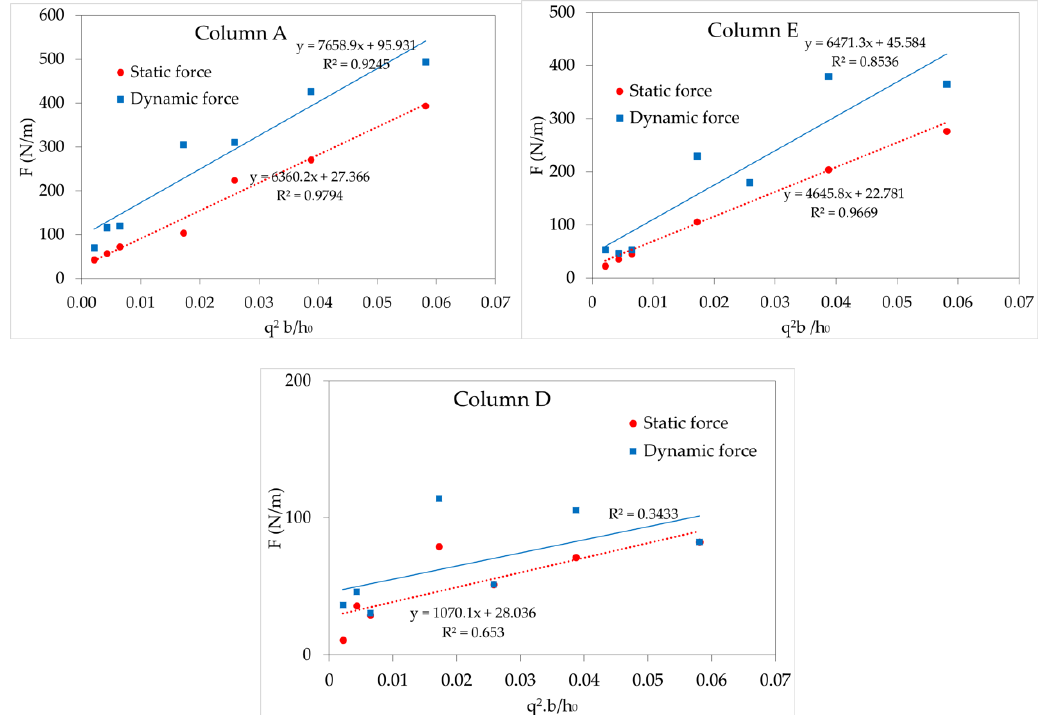
Figure 10. The linear regression between forces per unit width (F) and q 2 b/h 0 .